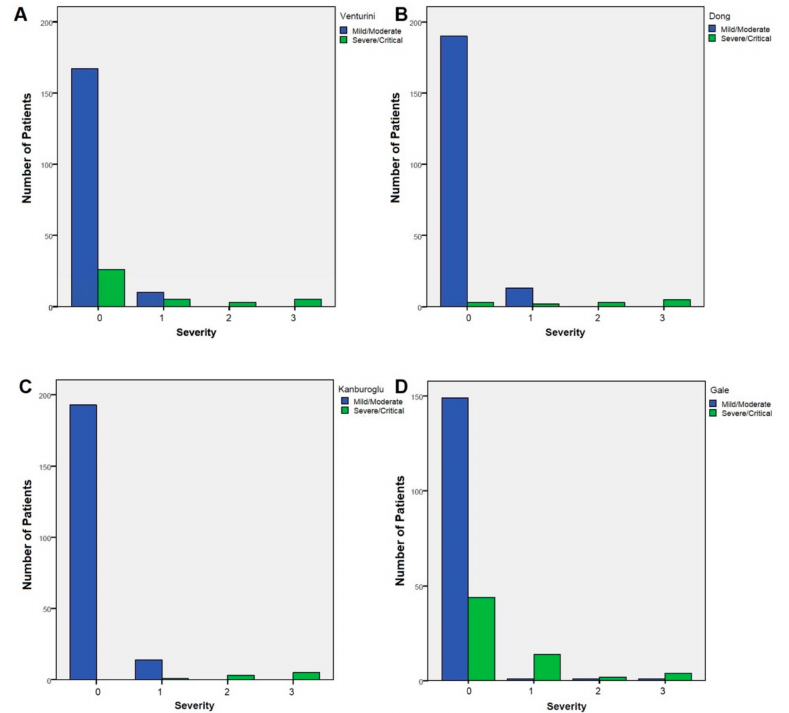
Figure 1. Distribution of patients classified as mild/moderate (blue bars) vs severe/critical (green bars) according to the Venturini ( A ) Dong ( B ) Kanburoglu ( C ), and Gale ( D ) severity scores among the a posteriori severity score assigned to all 216 enrolled subjects based on their clinical presentation and